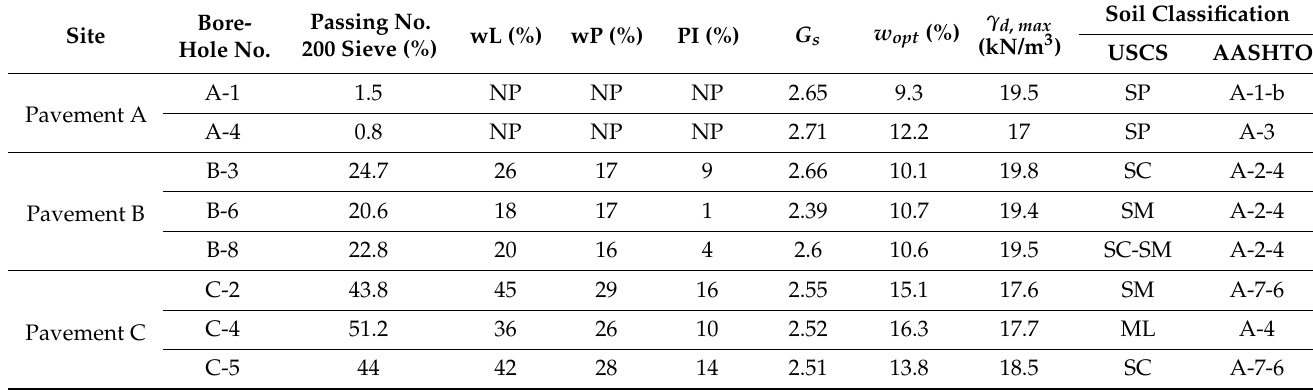
Table 2. Properties of Investigated Soils.